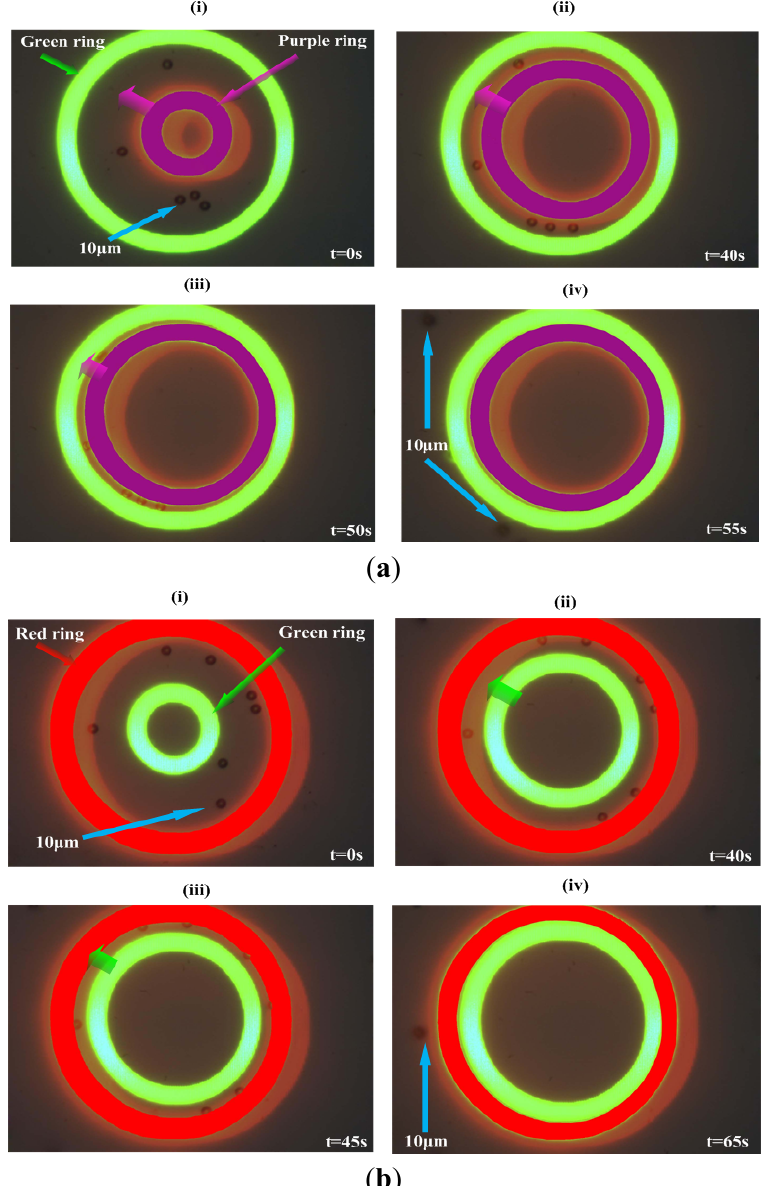
Figure 9. ( a ) Experimental results showing that the magnitude of the ODEP force induced by a purple color ring is higher than that induced by a green color ring. ( i ): A purple color ring (as an inner and moving ring) and a green color ring (outer and stationary ring) were projected onto the ODEP chip and no bias voltage was applied; ( ii ): Bias voltage was switched on (20 V , 30 kHz, square wave) and the purple ring was continuously enlarged. p-p Then, the 10 μ m polystyrene beads were pushed toward the inner edge of the green ring; ( iii ): The beads stayed between the gap of the two rings when the gap was equal to or greater than the diameter of the beads; iv : The purple ring continues to expand and pushes the bead through the green ring; ( b ) Experimental results for green and red rings using the process as described in (a). The experimental results confirm that higher frequency light colors can generate higher magnitude ODEP force. Note that the color ring images were enhanced manually as color filtering and optical refraction blurs any non-green colors, i.e ., only green rings are shown clearly in our ODEP microscope